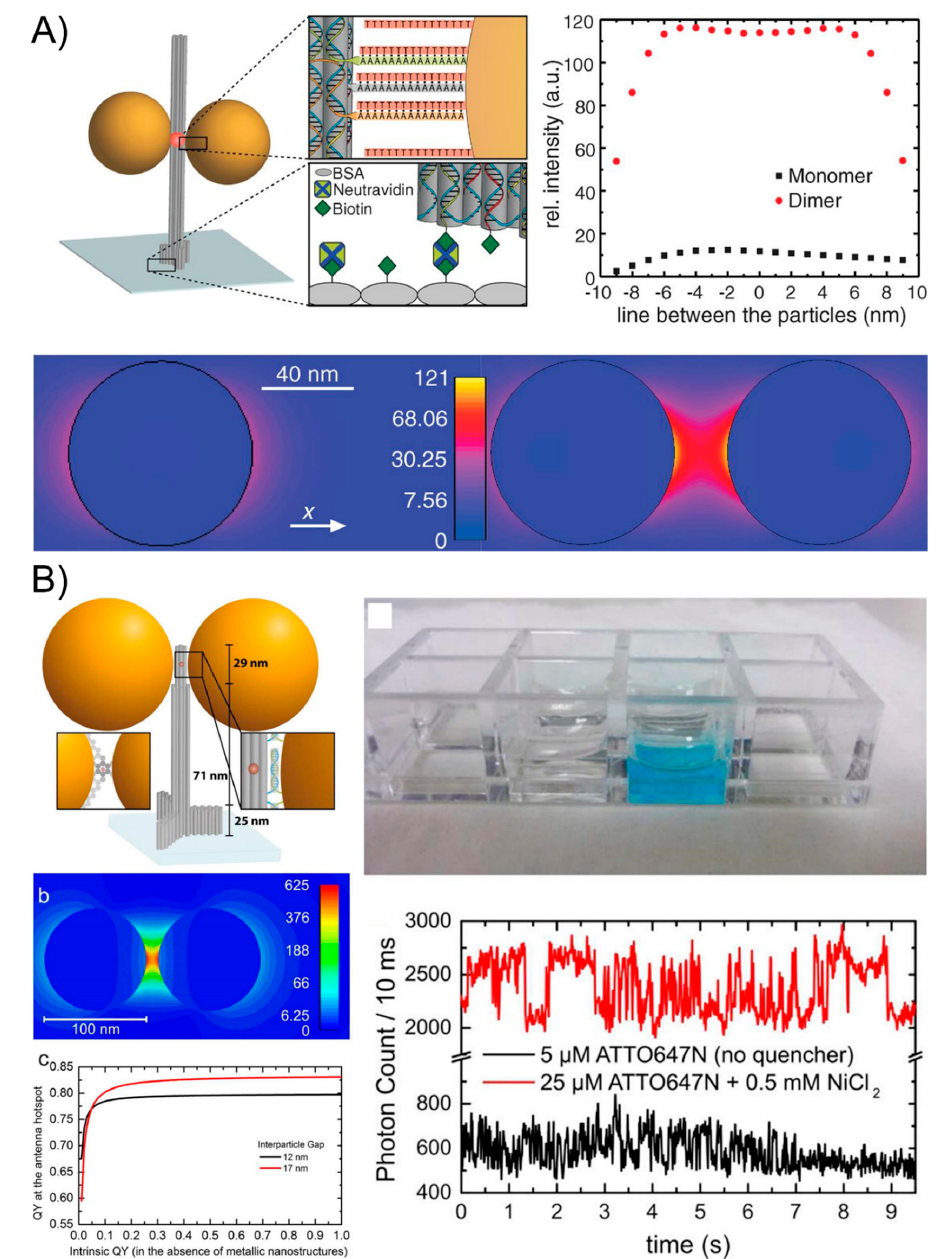
Figure 7. The surface-enhanced fluorescence of DNA-directed AuNP nanoarchitectures. ( A ) The fluorescence enhancement of up to 117-fold by attaching two AuNPs to DNA origami pillars and docking a single fluorescent dye in the vicinity of the AuNP dimers. ( B ) The new generation of DNA origami nanoantennas used to achieve a maximal fluorescence enhancement of 5468 and single-molecule detection with a 25- µ M background fluorophore concentration. Reproduced with permission from Reference [98]. Copyright American Association for the Advancement of Science, 2012; Reproduced with permission from Reference [99]. Copyright American Chemical Society, 2015.